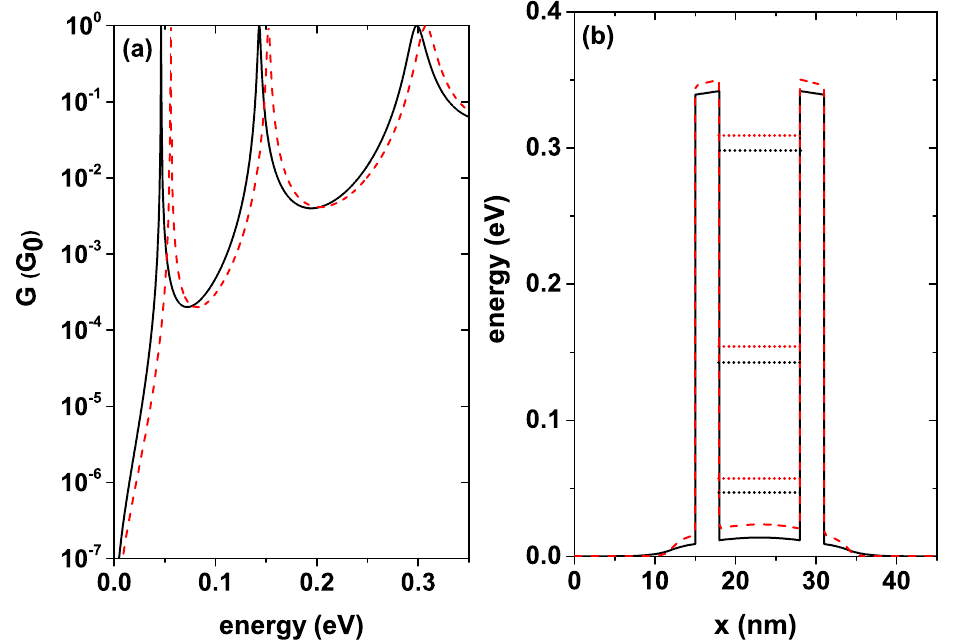
Figure 9. ( a ) Conductance for L w = 10nm, for two different donor concentrations in units of G 0 = e 2 / π ¯ h 2 , solid black line n d = 1.2 × 10 18 [1/cm 3 ], and dashed red line n d = 10 × 10 18 [1/cm 3 ]. ( b ) Corresponding self-consistent potentials. The curves were calculated at T =